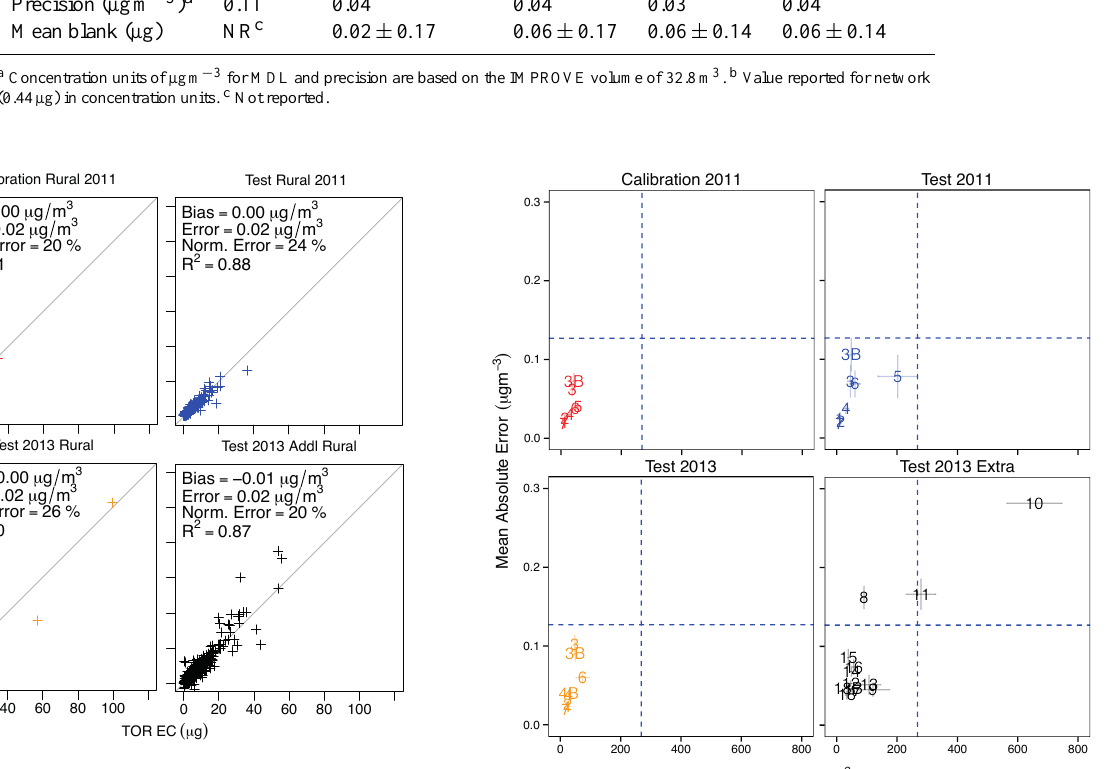
Figure 10. Scatter plots and performance metrics between FT-IR EC and TOR EC for the rural sites of the four data sets described in Sect. 2.1. Concentration units of µgm − 3 for bias and error are based on the IMPROVE nominal volume of 32.8m 3 .